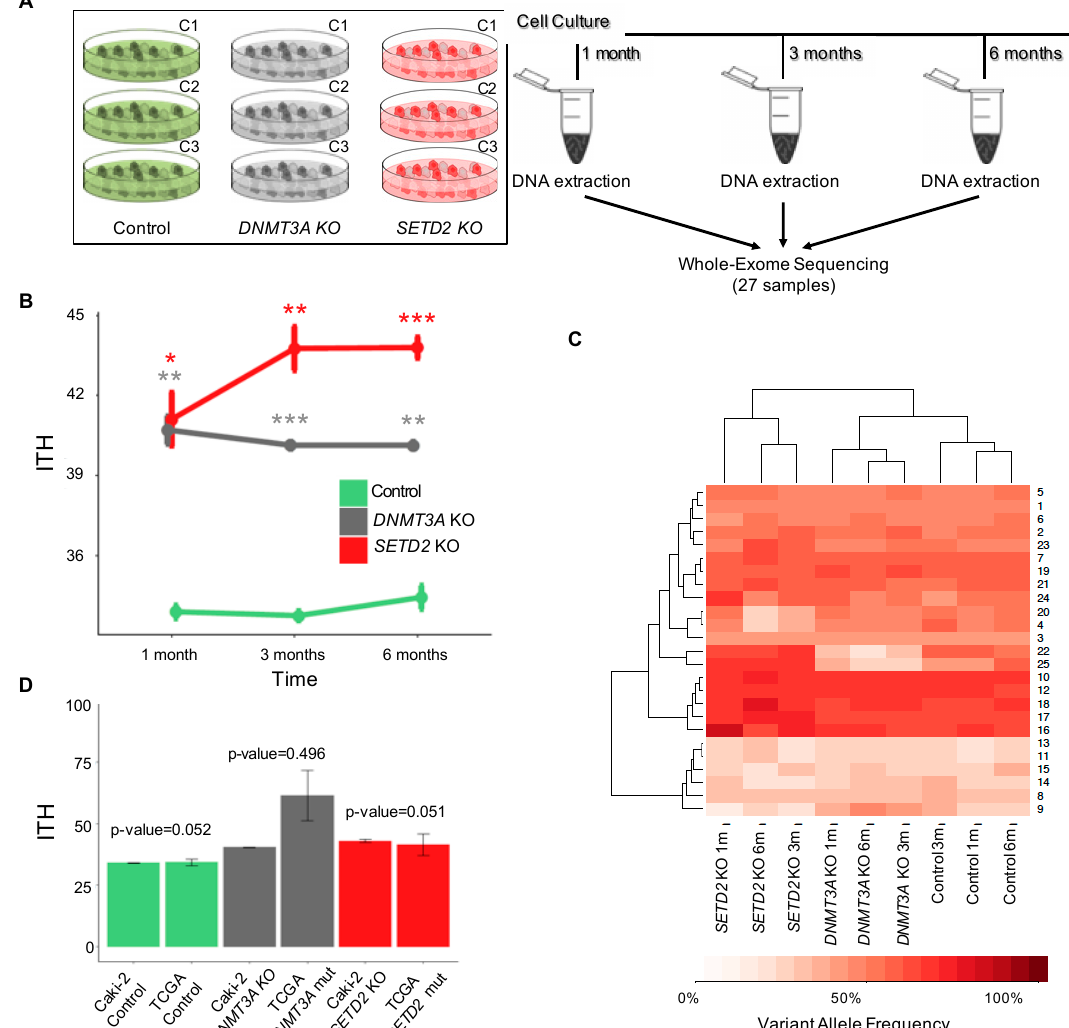
Figure 4. SETD2 and DNMT3A knockout drive ITH. ( A ) Schematic representation of the experimental setup. Control and knockout cells were cultured during the indicated time periods before DNA extraction and whole-exome sequencing (WES). ITH was inspected after three independent clonal expansions (C1 – C3) for each knockout at each time point. ( B ) ITH levels of SETD2 and DNMT3A knockout cells after 1, 3 and 6 months. WES data of the indicated conditions were used to calculate ITH, as described in the Methods. Data from three independent clonal expansions analyzed per group are presented as mean ± SEM. Statistical analysis was a two-tailed Student’s t -test (* p < 0.05, ** p < 0.01, *** p < 0.001). ( C ) Hierarchical cluster analysis of the mean variant allele frequency estimated with PyClone in control, SETD2 and DNMT3A knockout cells. ( D ) Distribution and comparison of the ITH levels across KIRC patients from TCGA and Caki-2 cell lines for the indicated conditions (control, SETD2 and DNMT3A knockouts). The bar graph displays mean ITH values and s.e.m. (standard error of the mean). Statistical analysis was performed with Wilcox-test but no statistical significance was observed between TCGA patients and each cell